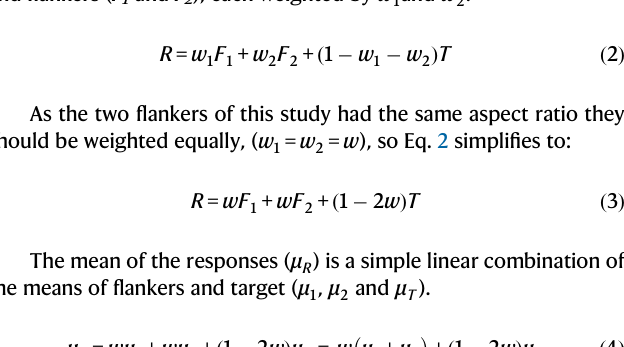
Thin dashed lines show best- fi tting derivative of gaussian, with all parameters free to vary (Eq. 18). b Response standard deviation as a function of the variable fl anker orientation. Conventions as in panel a . c Histogram of the centres of the gaussian derivative for 1000 bootstrap fi ts. Source data are provided as a Source Data fi